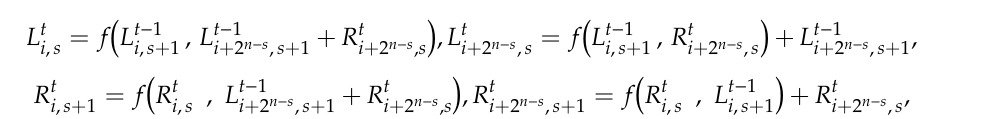
) at the left-most node s = 1.